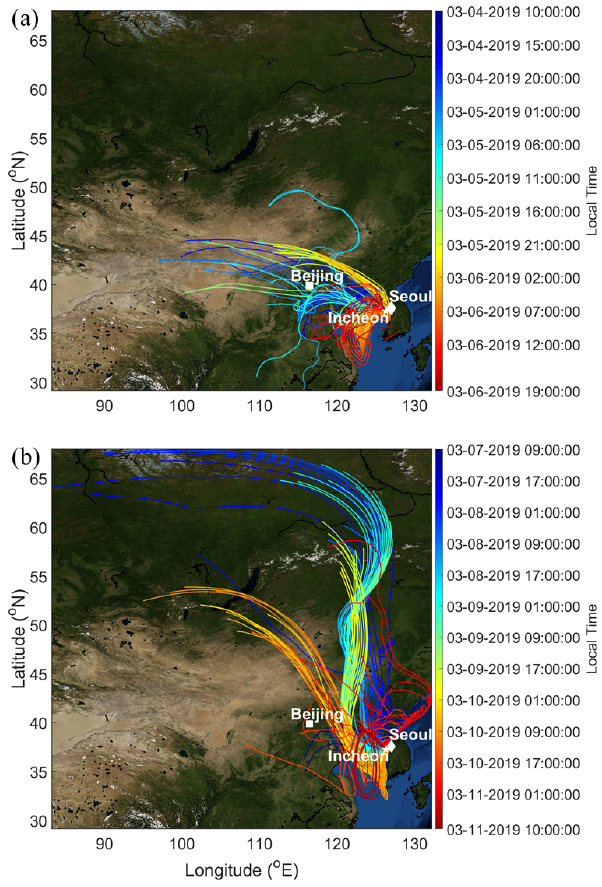
Figure 3. The 4d back trajectories based on hourly data during the (a) polluted and (b) the clean portion of the study period. The end- ing point of trajectories is at 500ma.g.l. at Incheon, with environ- mental parameters along the trajectories summarized in Fig. S4. Im- ages retrieved from https://worldview.earthdata.nasa.gov/ (last ac- cess: 15 November